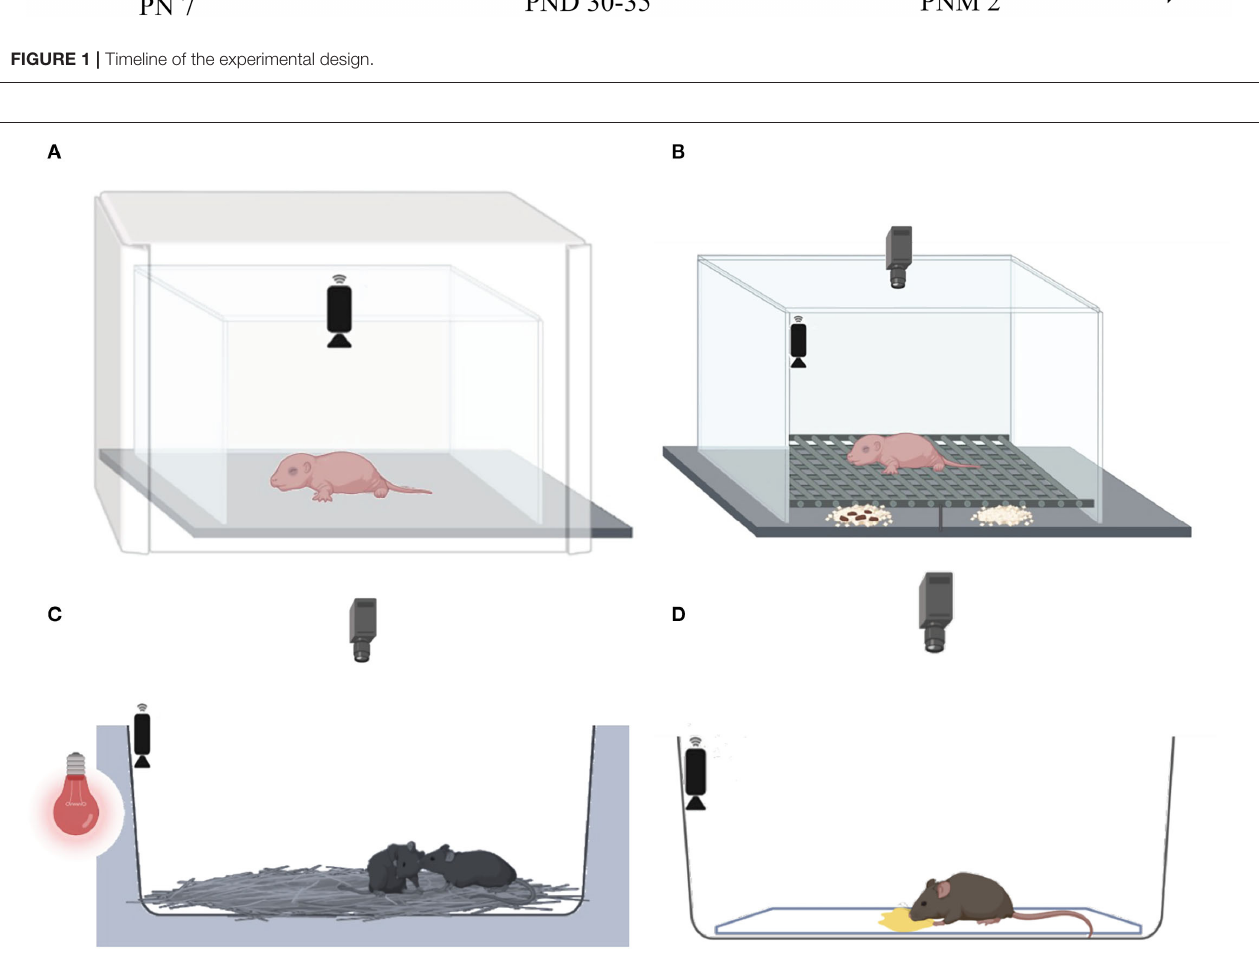
FIGURE 2 | Behavioral tests conducted at three developmental stages. (A) At PND 7, the maternal isolation-induced pup USV test, followed by (B) the home odor discrimination and preference test, (C) at PND 30–35, the juvenile social test, and (D) at 2–3 months, the female urine-induced USVs and scent-marking behavior